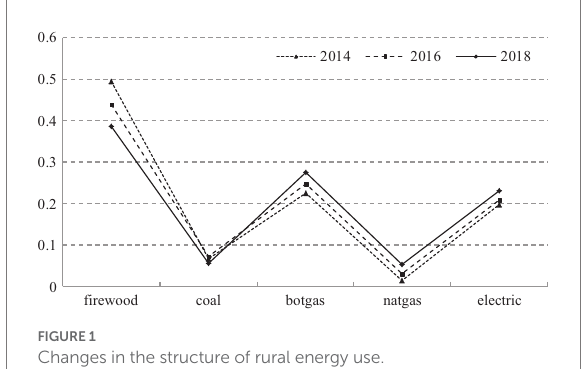
FIGURE 1 Changes in the structure of rural energy use.